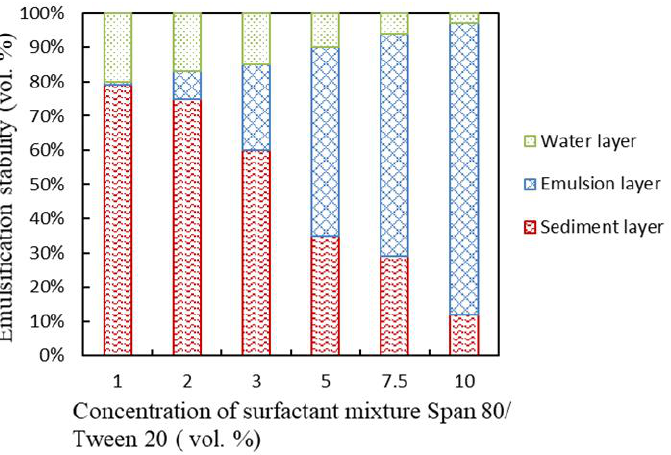
Figure 6. Effects of surfactant mixture of Span 80/Tween 20 concentrations on emulsification stability.